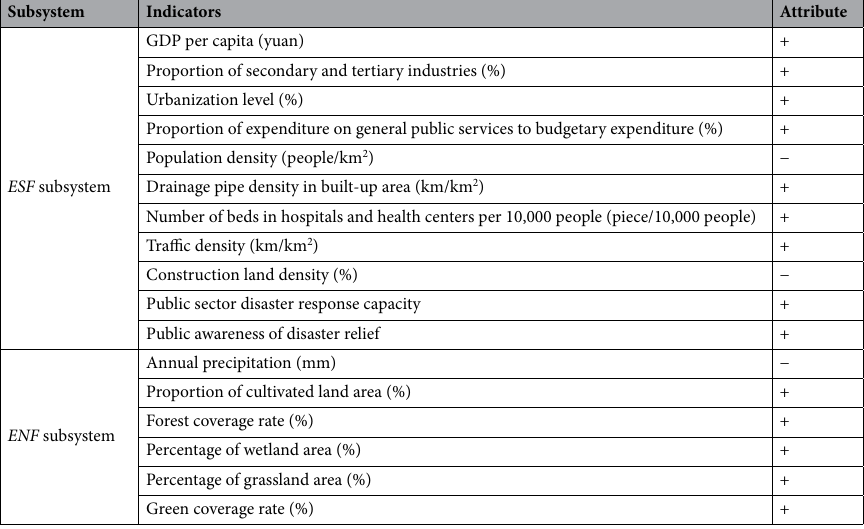
Table 1. Comprehensive evaluation index system. ESF economic-social factors, ENF environmental-natural